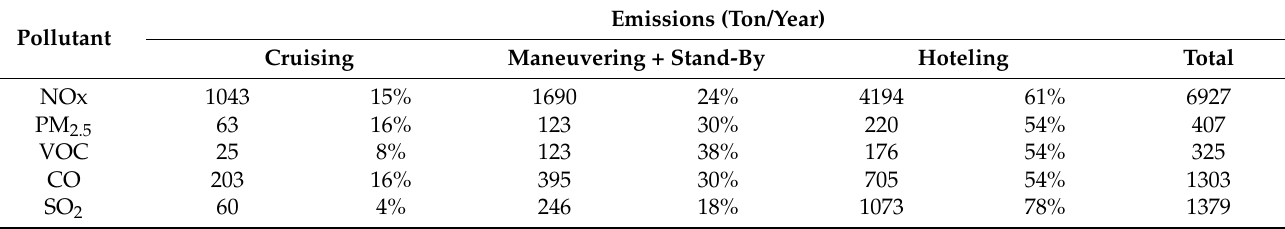
Table A23. Total emissions from vessels (Ashdod, BAU 2030).